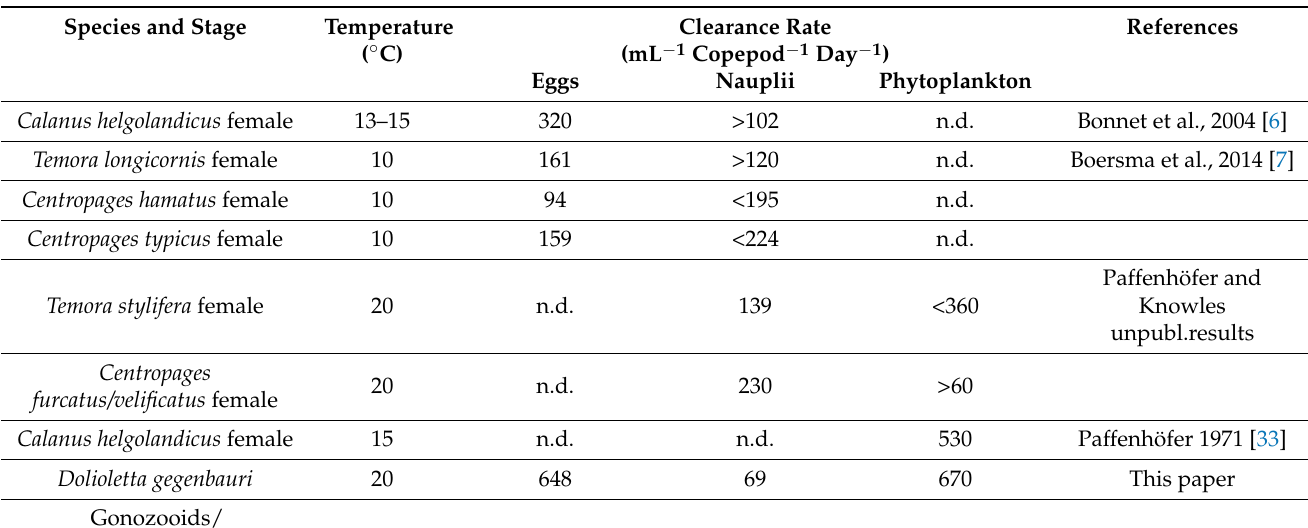
Table 1. Average clearance rates on copepod eggs and nauplii and phytoplankton by calanoid copepods and doliolids (n.d.—not